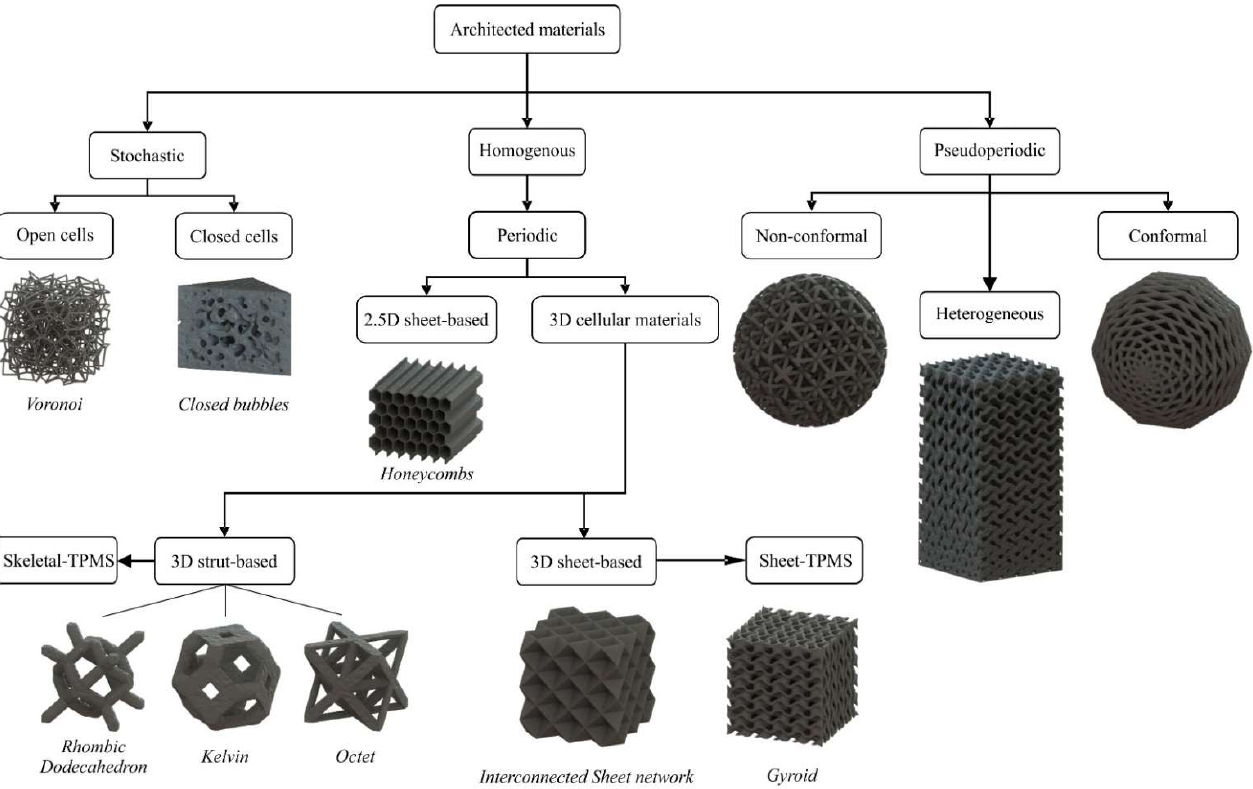
Figure 1. Classification of architected materials based on the